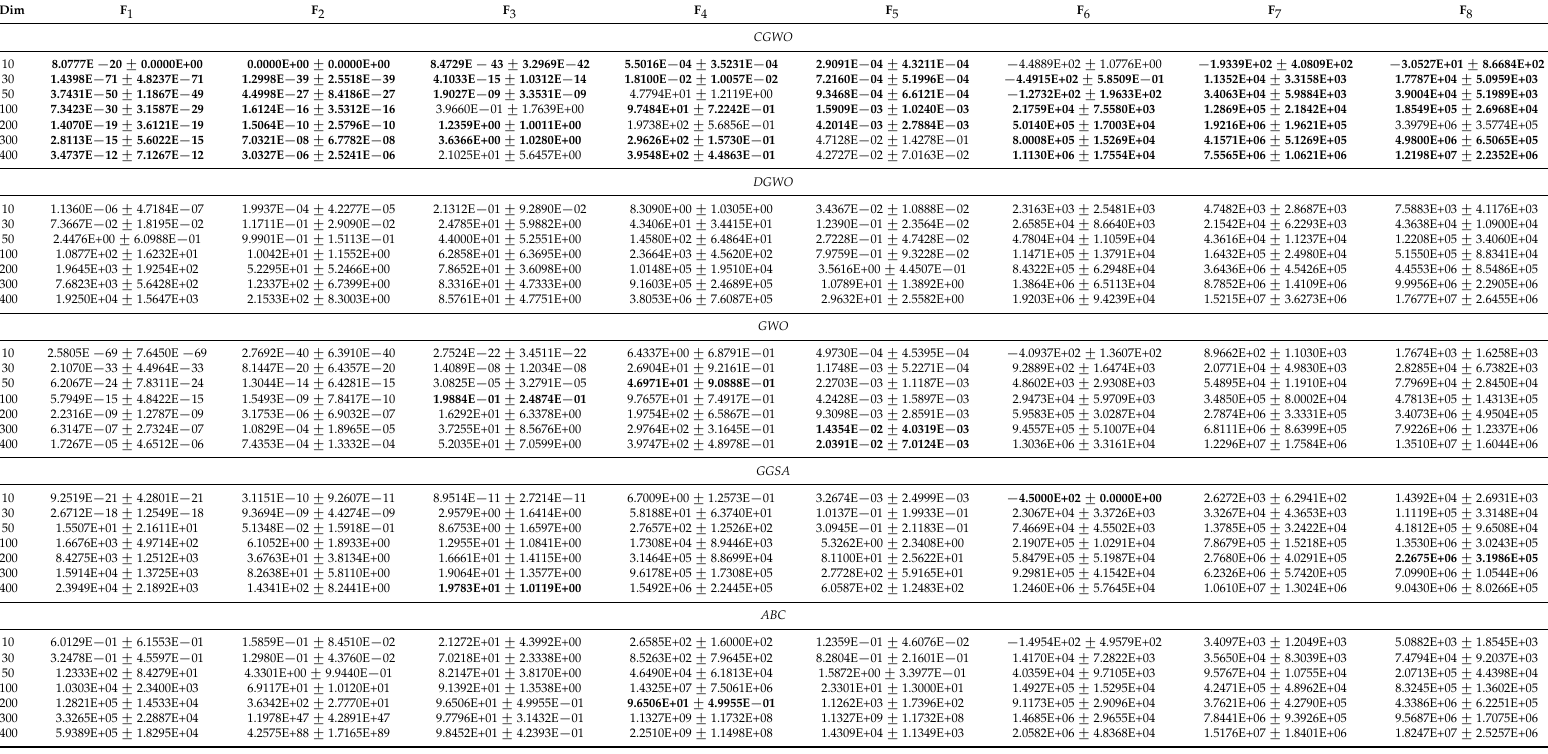
Table 4. Minimization results of the unimodal benchmark